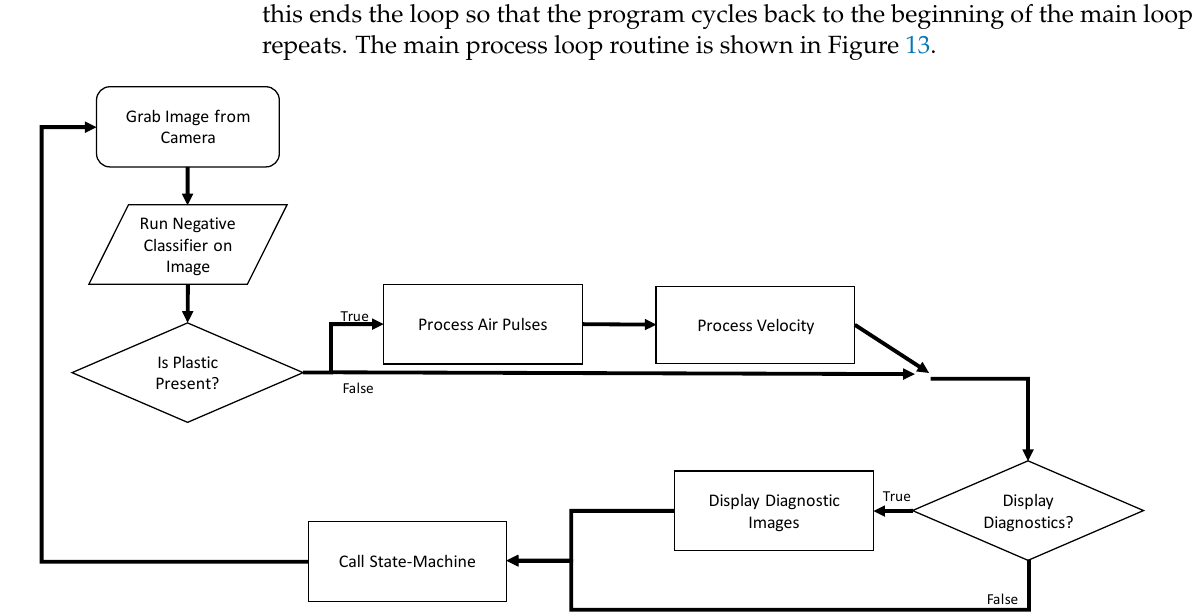
Figure 13. The flow chart for the main process loop.